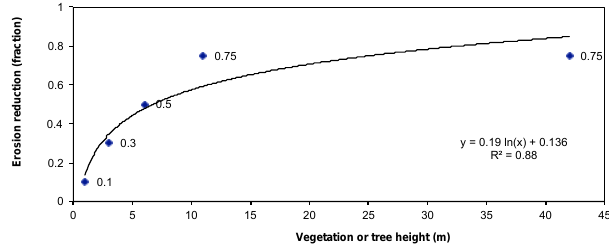
Figure 4. Relationship between tree height (as a proxy for root spread) and erosion reduction (bank stability) used to reduce GEP estimates. Relationship based on field